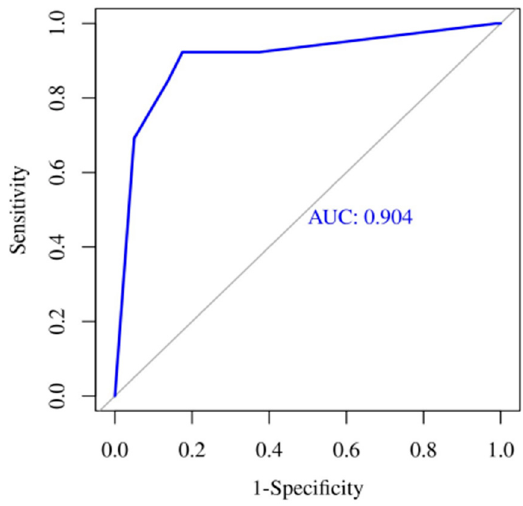
Figure 4. Multivariate ROC Curve for biomarkers at first evaluation.